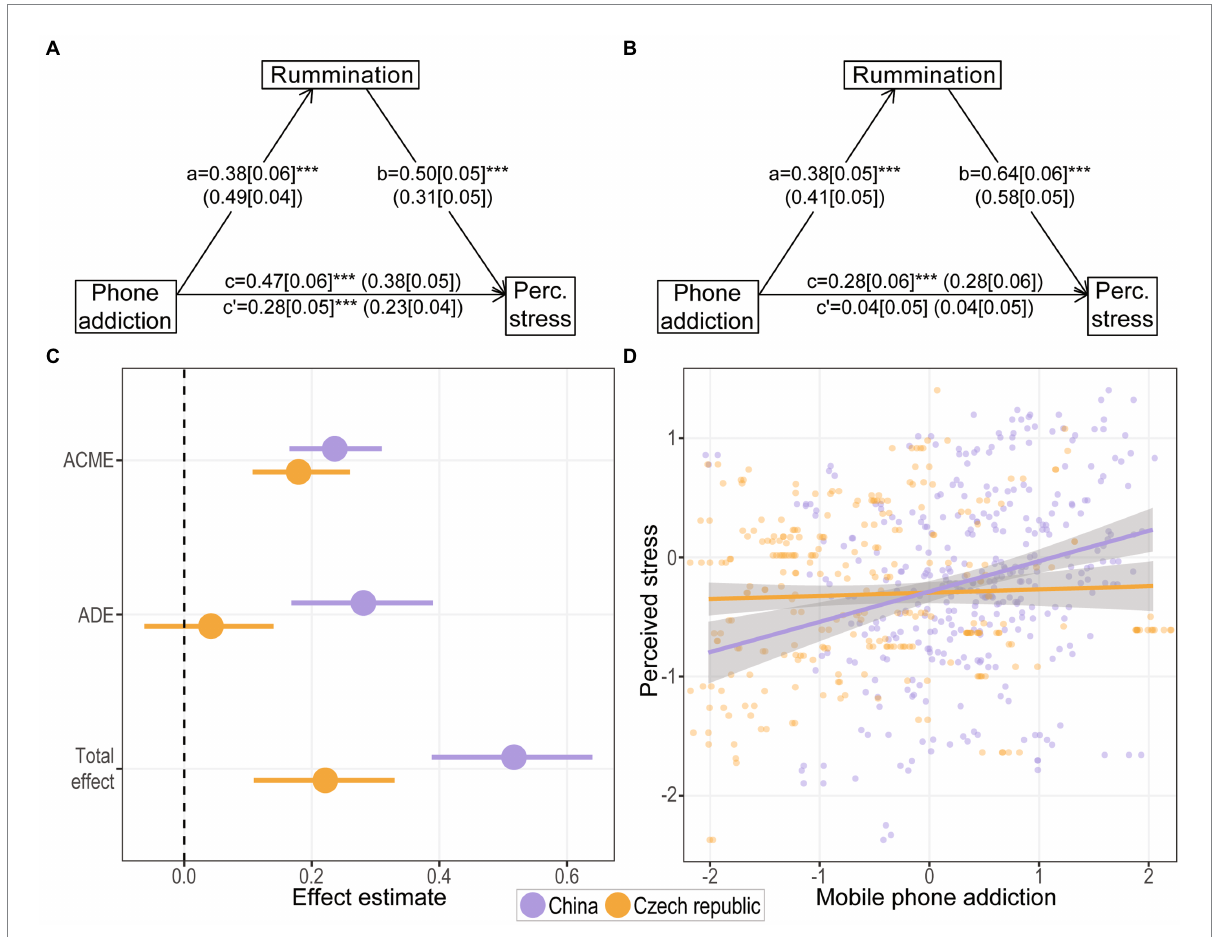
FIGURE 2 Casual mediation and moderated–mediation models. Simple mediation diagrams showing a, b, c, and c’ path coefficients for (A) Chinese and (B) Czech students, representing unstandardized regression weights with standardized regression weights in parentheses. The square brackets contain the SE. *** p < 0.001. The c path coefficient represents the total effect, the c-prime path coefficient refers to the direct effect. (C) Country– specific estimates of direct and indirect effects of mobile phone addiction on perceived stress with rumination as the mediator. (D) Direct effects of mobile phone addiction on perceived stress in both countries considering the mediating effect of